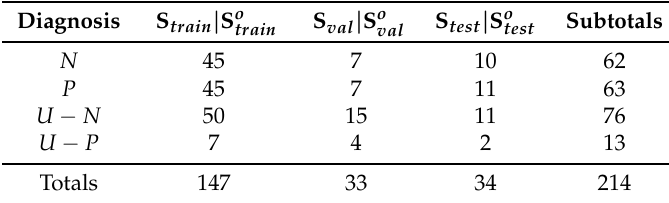
Table 2. Detailed composition of OSXR and ESXR